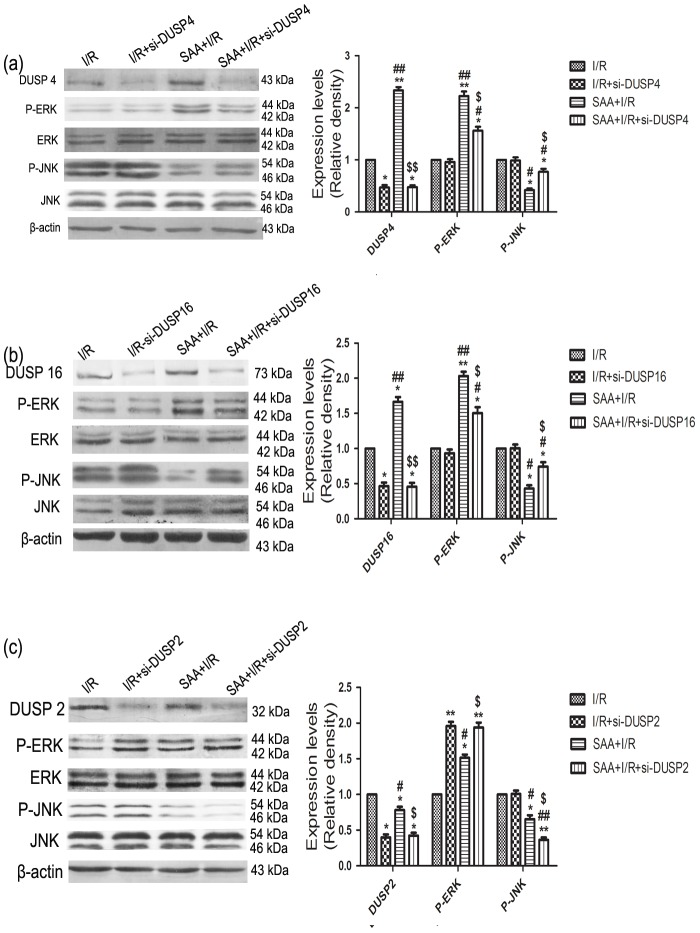
The effects of SAA and siRNA-DUSP2/4/16 on p-ERK and p-JNK.(a) Effects of SAA and siRNA-DUSP4 on p-ERK(44 KDa, 42 KDa) and p-JNK(54 KDa, 46 KDa); (b) Effects of SAA and siRNA-DUSP16 on p-ERK and p-JNK; (C) Effects of SAA and siRNA-DUSP2 on p-ERK and p-JNK; Cardiomyocytes was transfected siRNA-DUSP2/4/16, then SAA pretreatment for 30 min before I/R. All data were expressed as mean ±SEM, n = 3, *P<0.05, **P<0.01 versus I/R group. #P<0.05, ##P<0.01 versus si-DUSP+I/R group. $P<0.05, $$P<0.01versus SAA+ I/R group.